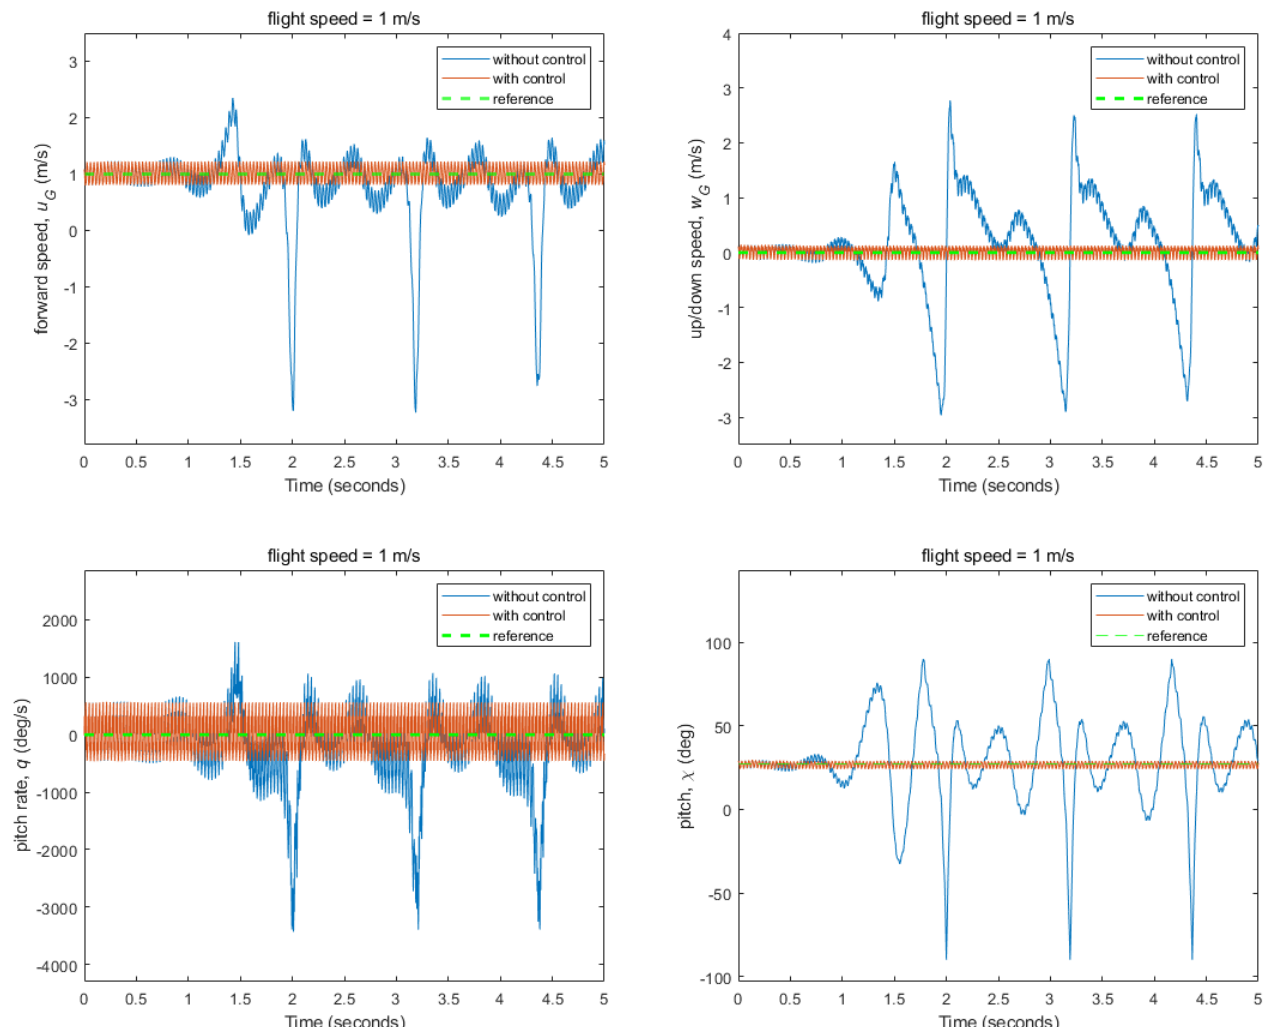
Figure 18. Flight control simulations for forward flight control (flight speed = 1 m/s).